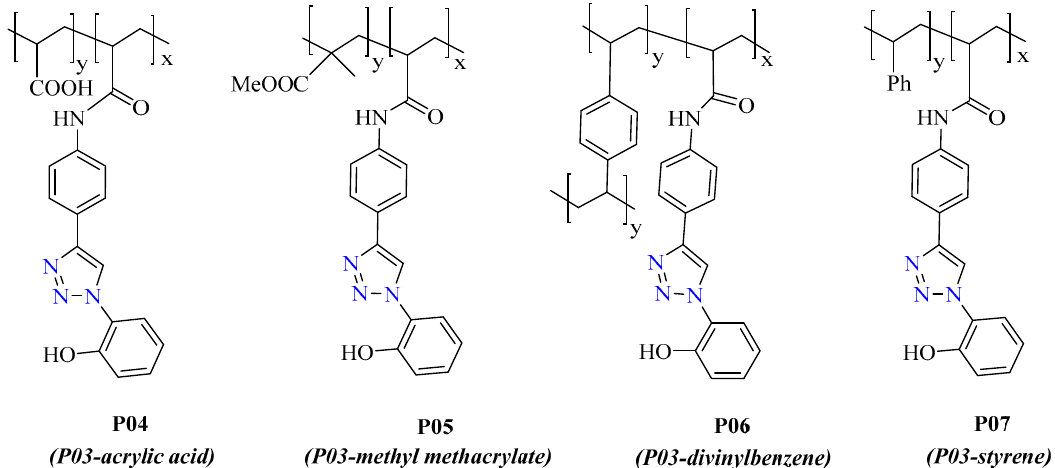
Figure 1. Structures of PTP -based polymeric chemosensors.